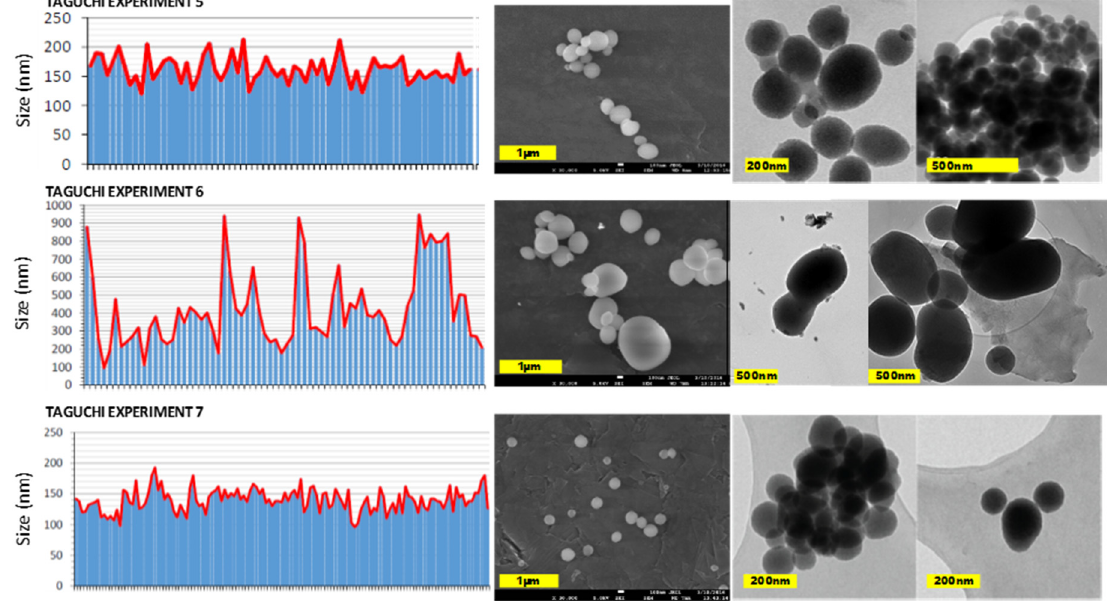
Figure 3. Micrograph-based size distribution, Scanning Electron Microscopy (SEM) and Transmission Electron Microscopy (TEM) images obtained for Taguchi experiments 5, 6 and 7.